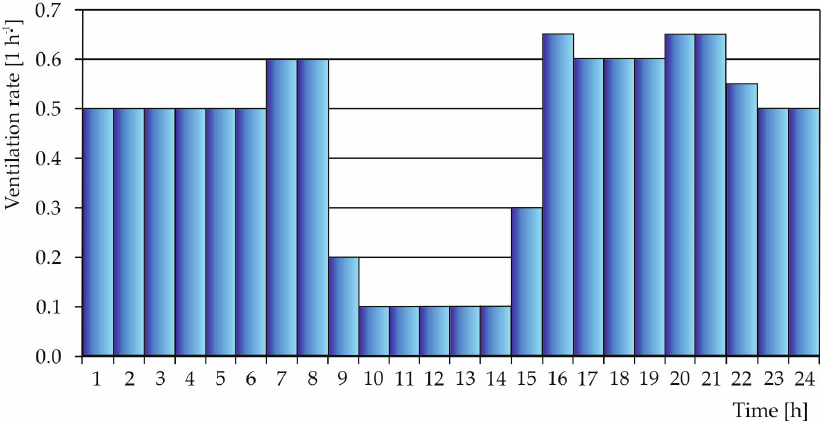
Figure 4. Optimum multiplicity of air exchange n k throughout a standard weekday.